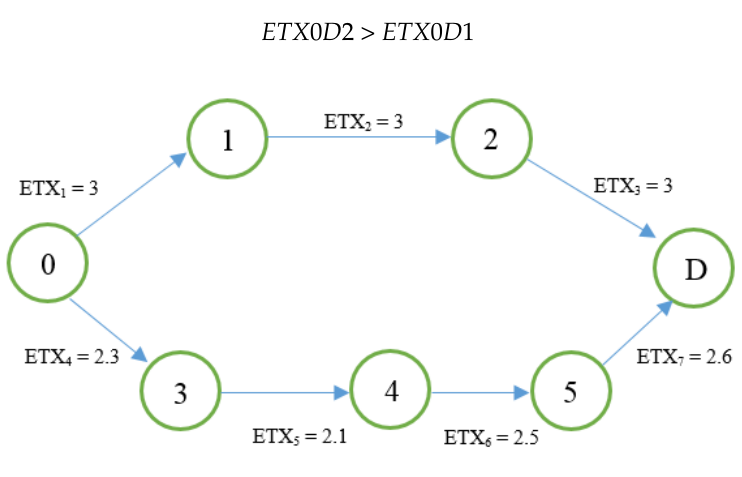
Figure 1. Sample PH ETX.